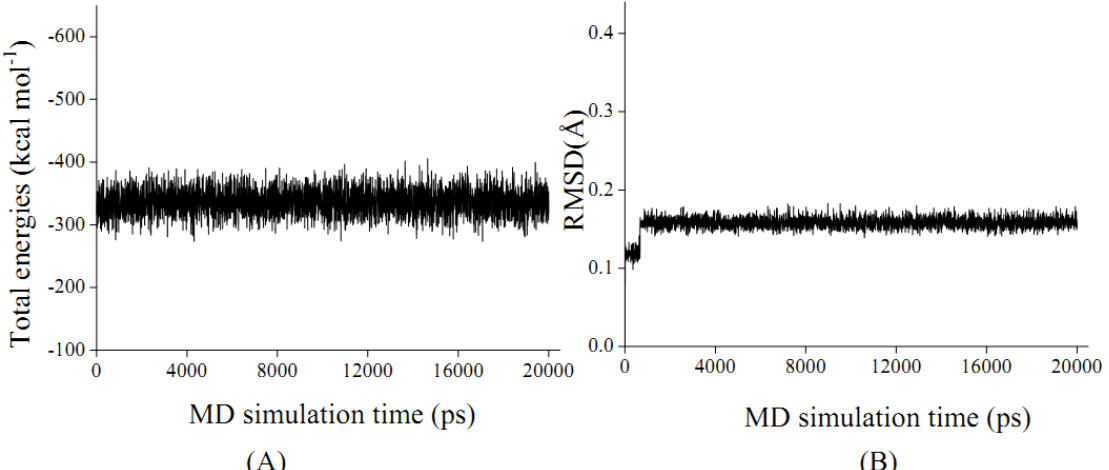
Figure 3. The total energies of ensemble (Total energies, A) and time-evolution backbone-atom root mean square deviations (RMSD, B) during the molecular dynamic (MD) simulations for the NA protein complexed with patchouli